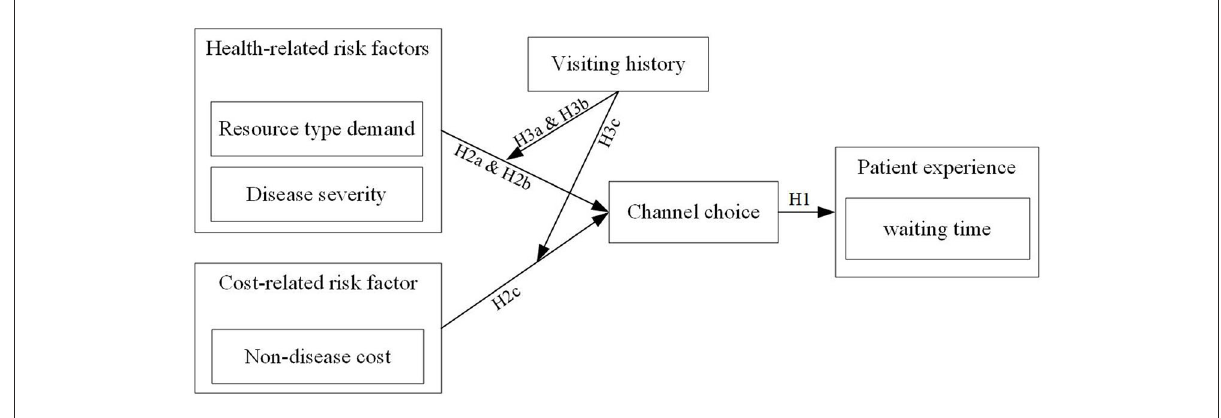
FIGURE2 The conceptual